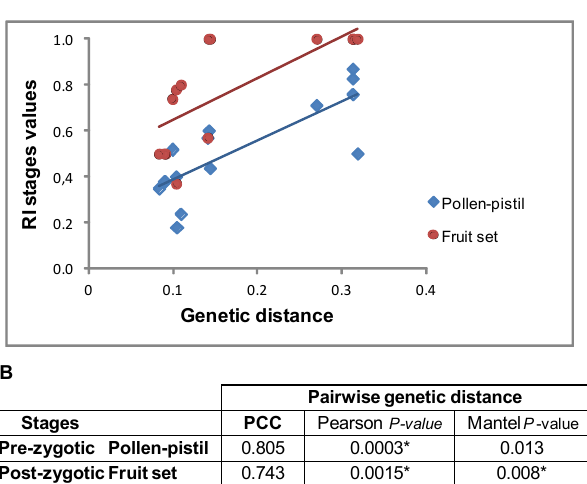
Figure 10. Relationship between pairwise genetic distance and reproductive isolation stages. ( A ) Correlation plots between Nei’s (1972) genetic distance and RI values for pollen-pistil interaction and fruit set stages; ( B ) Statistical significance of the relationship between pairwise genetic distance and RI stages assessed by Pearson’s correlation coefficient (PCC) and Mantel tests (significant values p < 0.01 *).